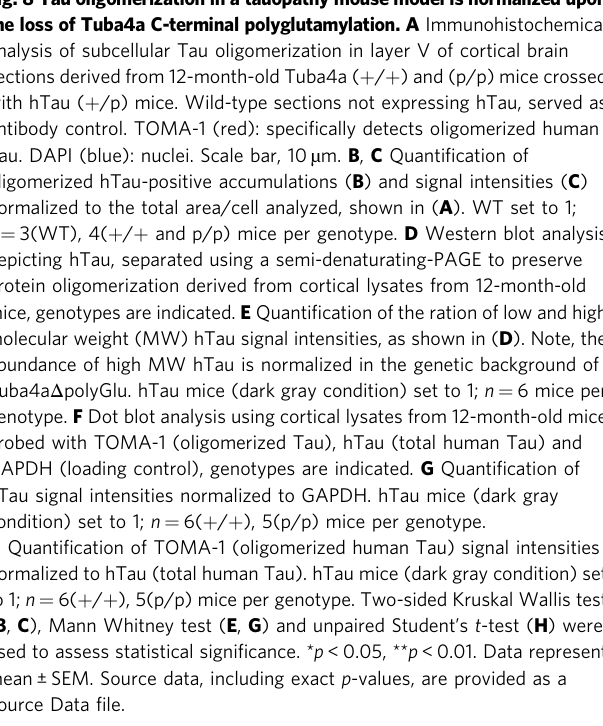
Fig. 8 Tau oligomerization in a tauopathy mouse model is normalized upon the loss of Tuba4a C-terminal polyglutamylation. A Immunohistochemical analysis of subcellular Tau oligomerization in layer V of cortical brain sections derived from 12-month-old Tuba4a ( + / + ) and (p/p) mice crossed with hTau ( + /p) mice. Wild-type sections not expressing hTau, served as antibody control. TOMA-1 (red): speci fi cally detects oligomerized human Tau. DAPI (blue): nuclei. Scale bar, 10 µ m. B , C Quanti fi cation of oligomerized hTau-positive accumulations ( B ) and signal intensities ( C ) normalized to the total area/cell analyzed, shown in ( A ). WT set to 1; n = 3(WT), 4( + / + and p/p) mice per genotype. D Western blot analysis depicting hTau, separated using a semi-denaturating-PAGE to preserve protein oligomerization derived from cortical lysates from 12-month-old mice, genotypes are indicated. E Quanti fi cation of the ration of low and high molecular weight (MW) hTau signal intensities, as shown in ( D ). Note, the abundance of high MW hTau is normalized in the genetic background of Tuba4a Δ polyGlu. hTau mice (dark gray condition) set to 1; n = 6 mice per genotype. F Dot blot analysis using cortical lysates from 12-month-old mice probed with TOMA-1 (oligomerized Tau), hTau (total human Tau) and GAPDH (loading control), genotypes are indicated. G Quanti fi cation of hTau signal intensities normalized to GAPDH. hTau mice (dark gray condition) set to 1; n = 6( + / + ), 5(p/p) mice per genotype. H Quanti fi cation of TOMA-1 (oligomerized human Tau) signal intensities normalized to hTau (total human Tau). hTau mice (dark gray condition) set to 1; n = 6( + / + ), 5(p/p) mice per genotype. Two-sided Kruskal Wallis test ( B , C ), Mann Whitney test ( E , G ) and unpaired Student ’ s t -test ( H ) were used to assess statistical signi fi cance. * p < 0.05, ** p < 0.01. Data represent mean ± SEM. Source data, including exact p -values, are provided as a Source Data fi le.